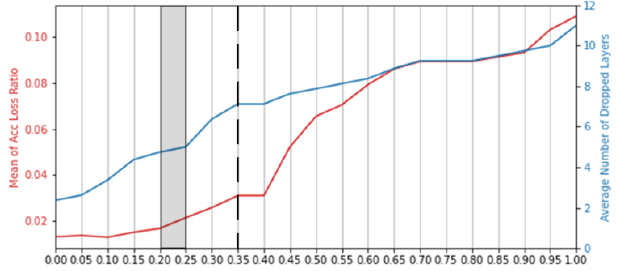
Figure 5. The mean accuracy loss ratio (the left vertical axis) and the number of dropped Transformer layers (the right vertical axis) vary when ρ changes from 0 to 1 with a stride of 0.05. The horizontal axis is the value of ρ . The vertical dashed line corresponds to the upper bound of ρ that can bring good trade-offs between accuracy loss and compression ratio. The gray interval corresponds to ρ ∈ [ 0.20, 0.25 ] , which can achieve the largest compression ratio without notable accuracy loss. Best viewed in color.